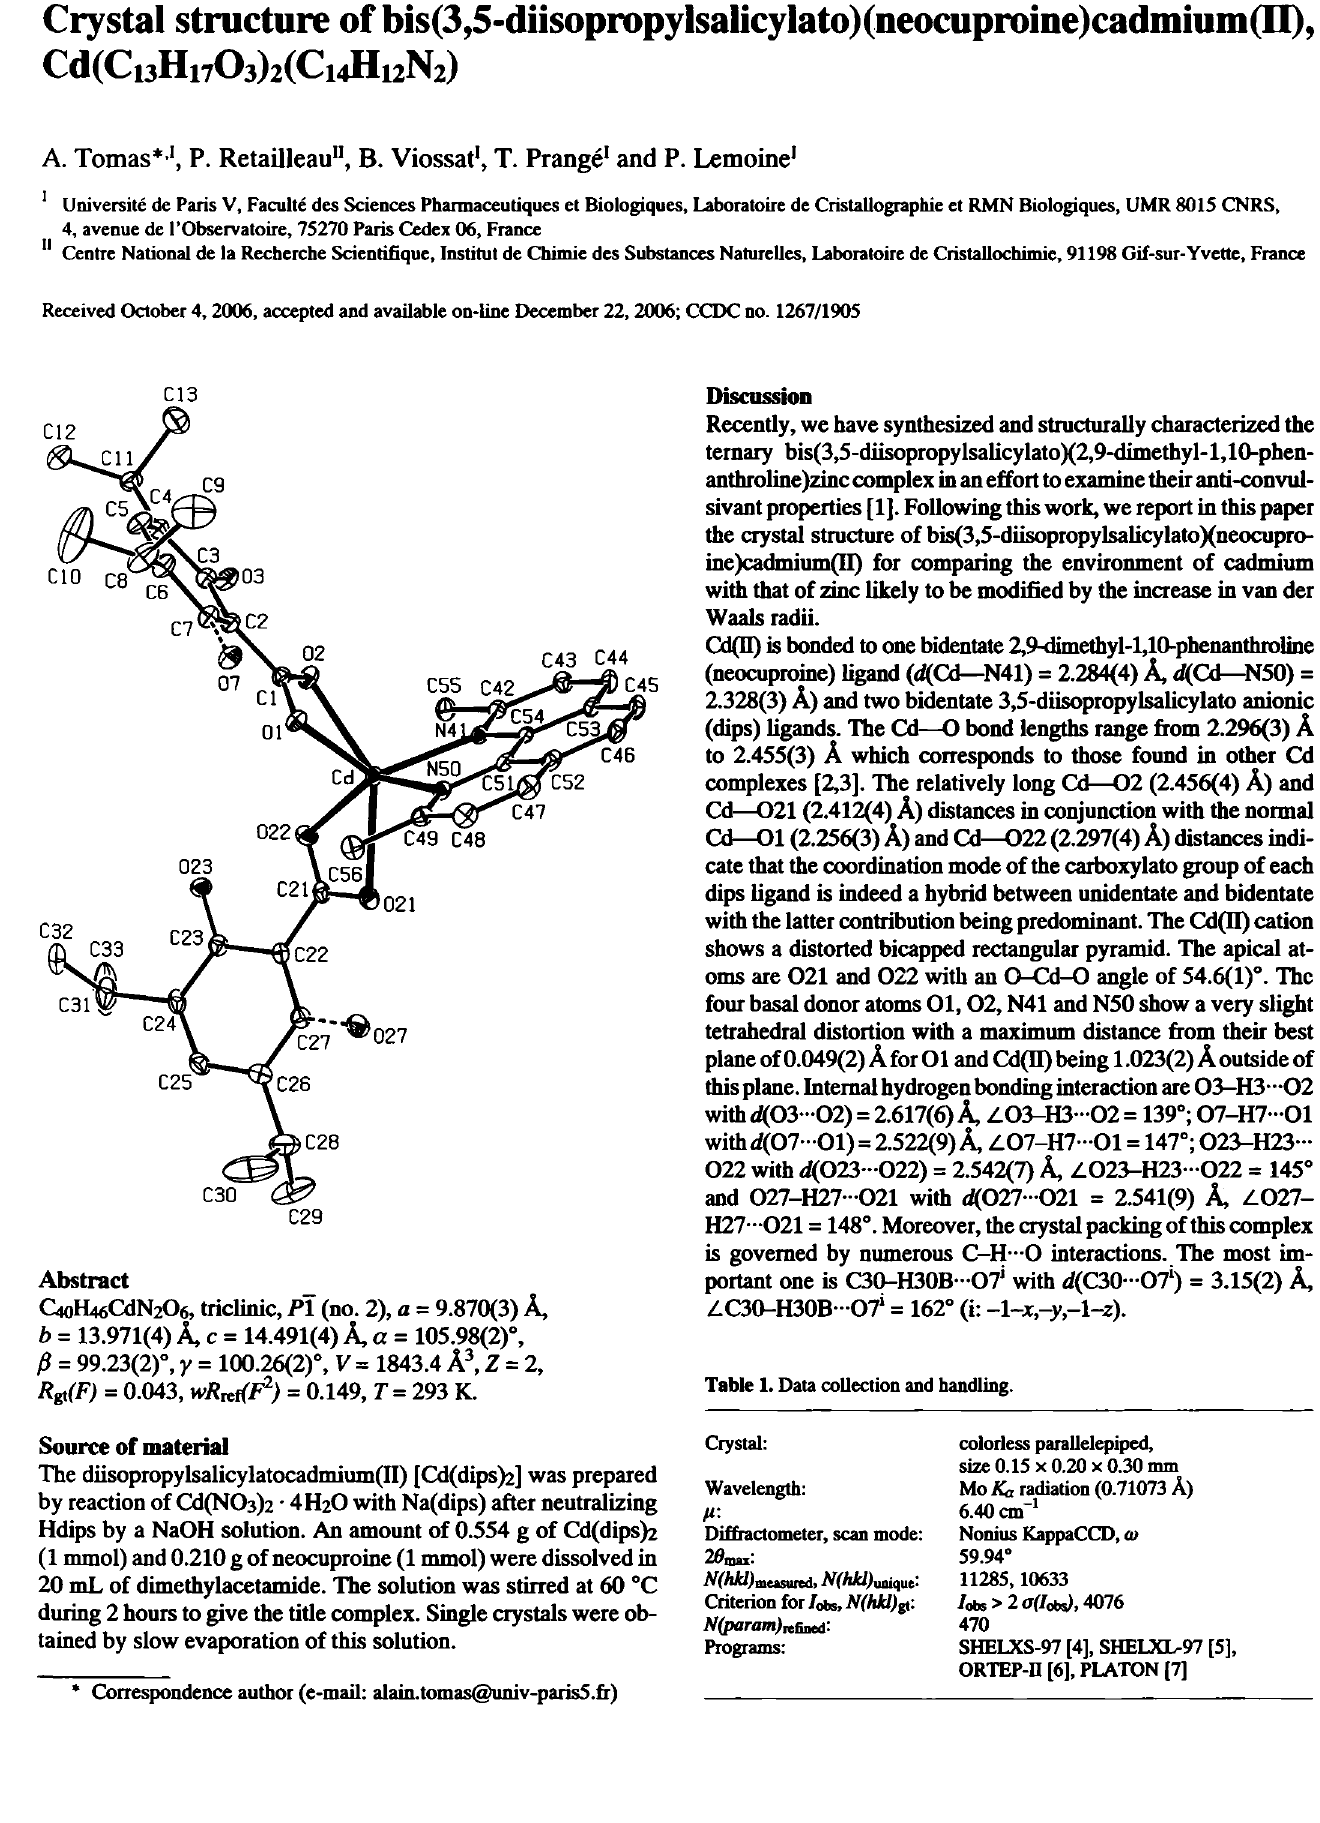
Table 1. Data collection and